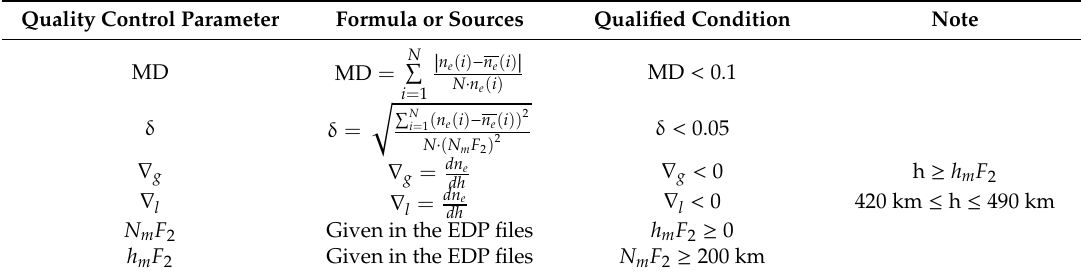
Table 1. Radio occultation (RO)-derived electron density profile (EDP) quality control criteria [40]. Quality Control